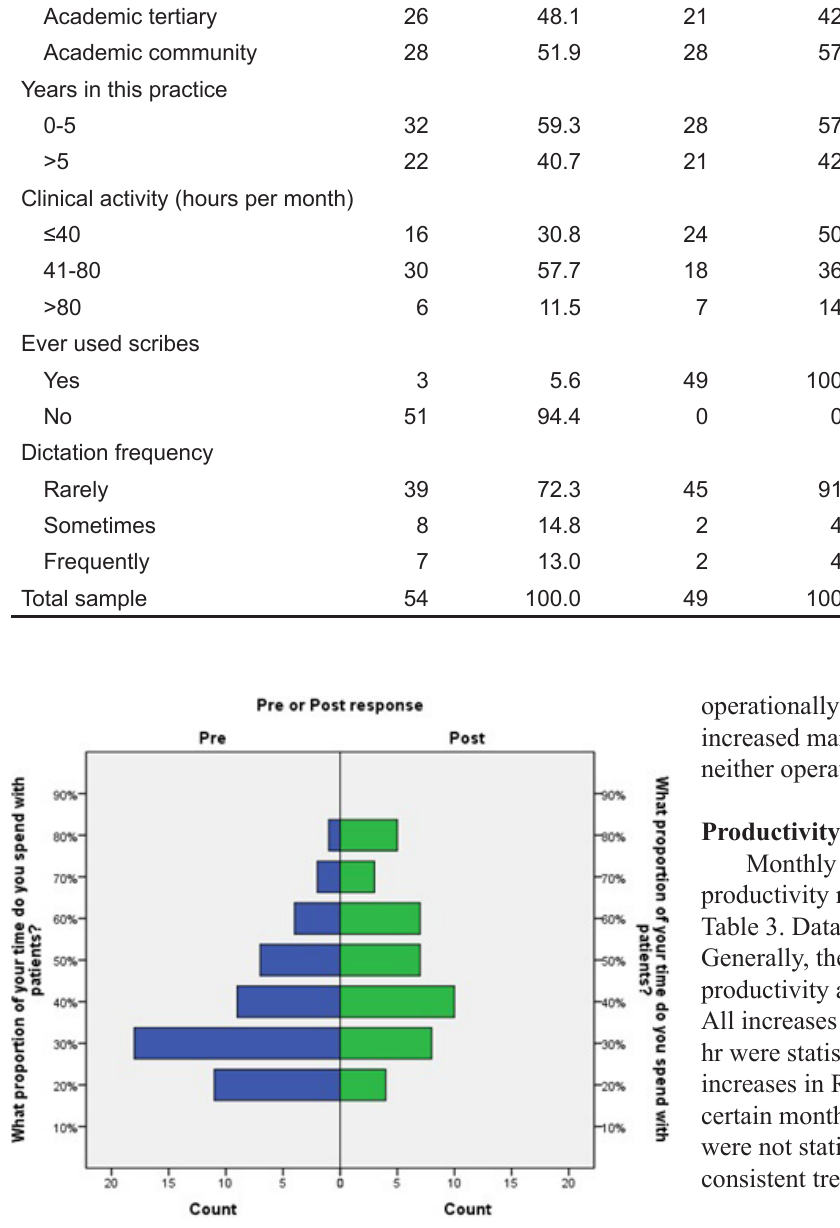
Figure 1. Pre- and post-intervention frequency distributions of reported proportion of shift time spent with